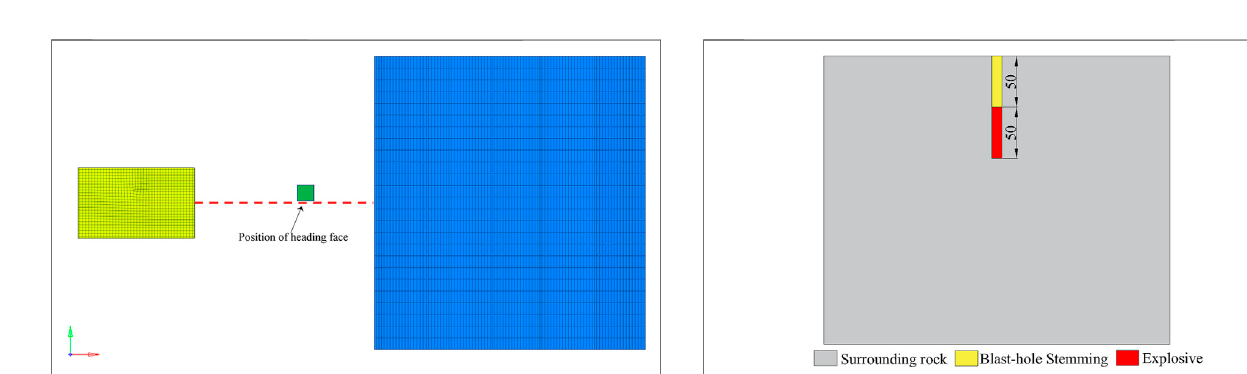
FIGURE 4 | Relative location of the heading face and adjacent structures.